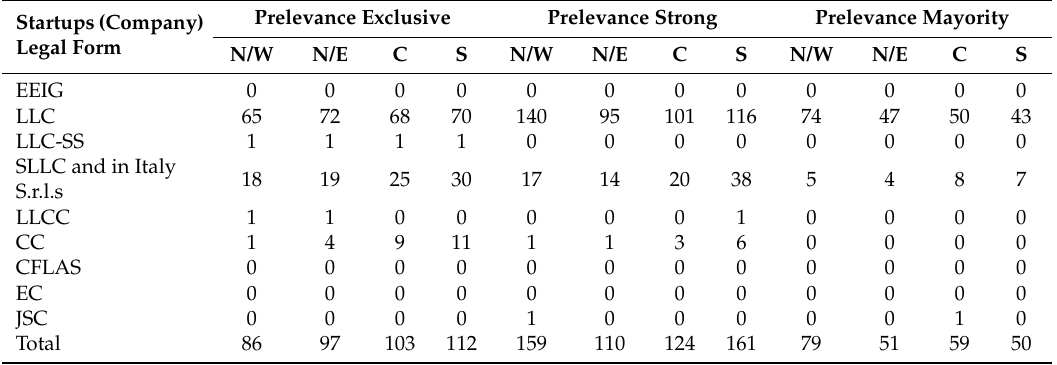
Table 8. Type of Italian woman startups (WSU) to geographical macroarea and to type of legal